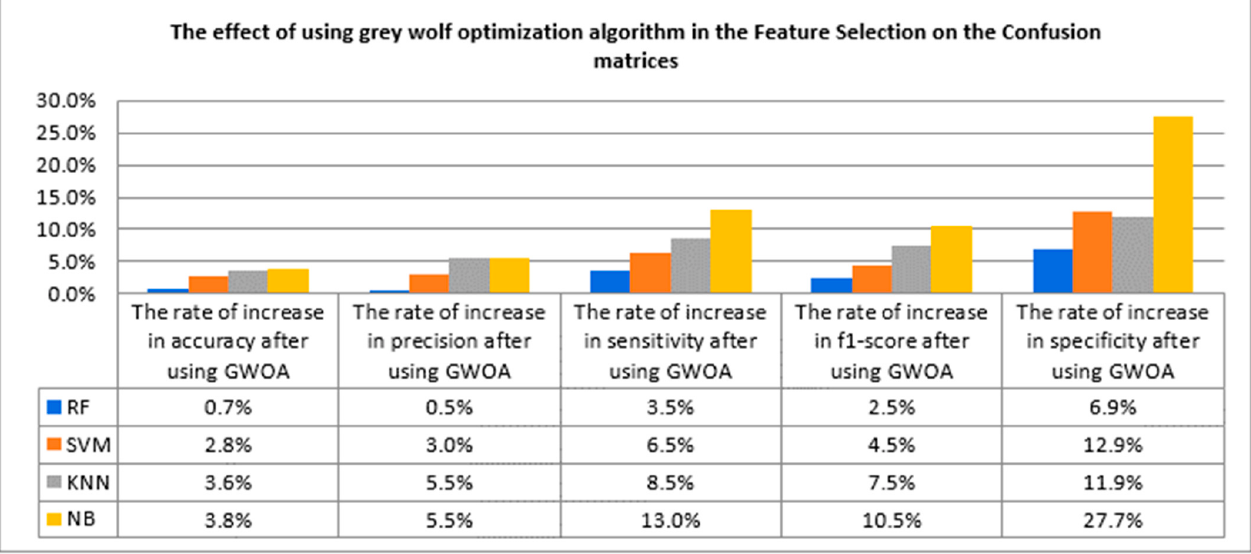
Figure 15. The rate of increase in confusion matrices after using grey wolf optimization algorithm.